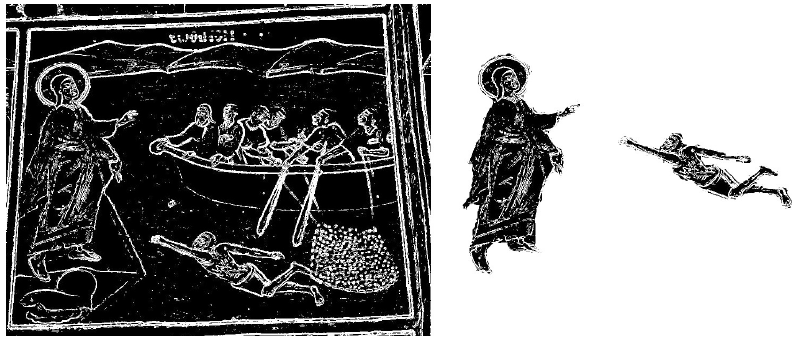
Figure 13. Example of selection and isolation of depicted